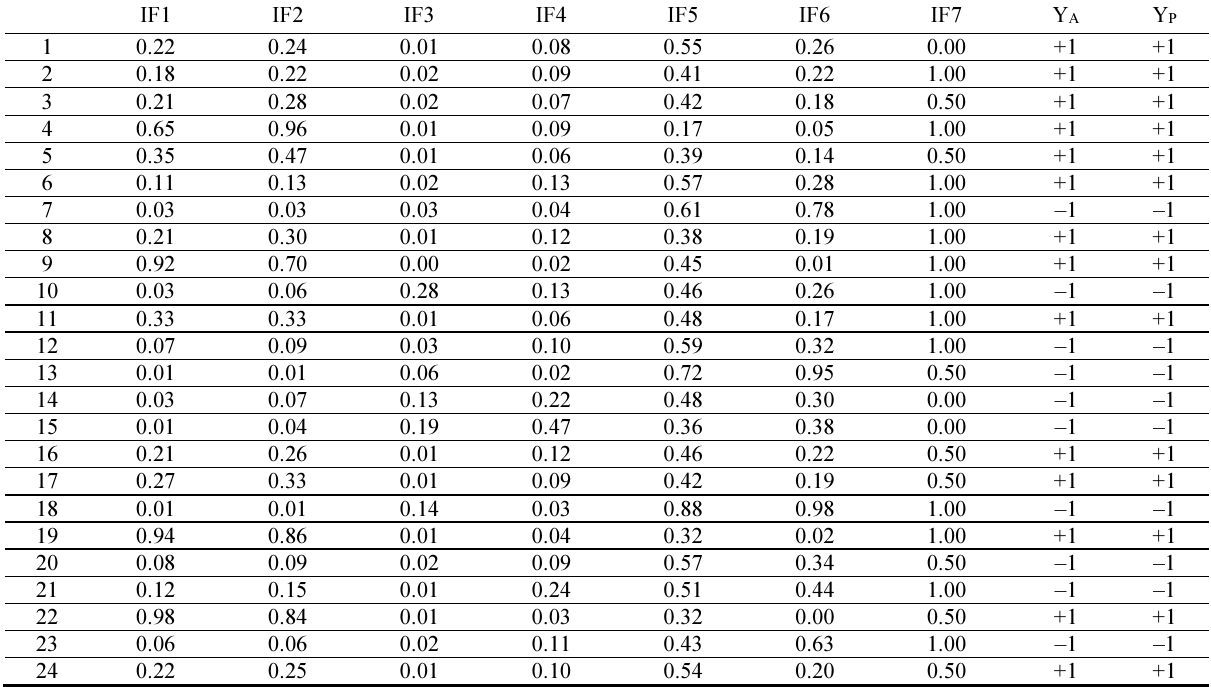
Table 6. Classification result of